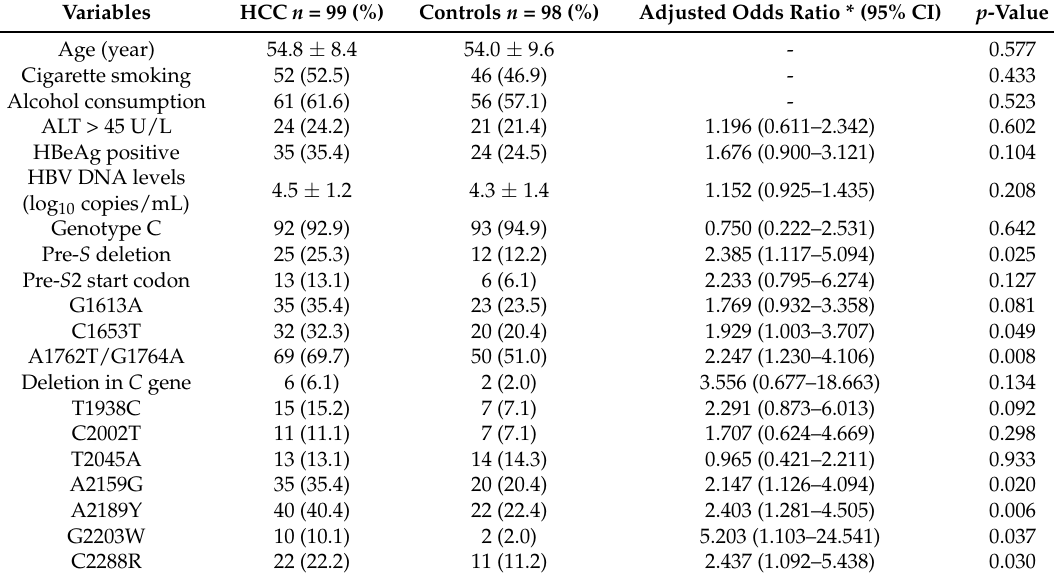
Table 3. Clinical and virologic characteristics of 99 HCC cases and 98 controls.